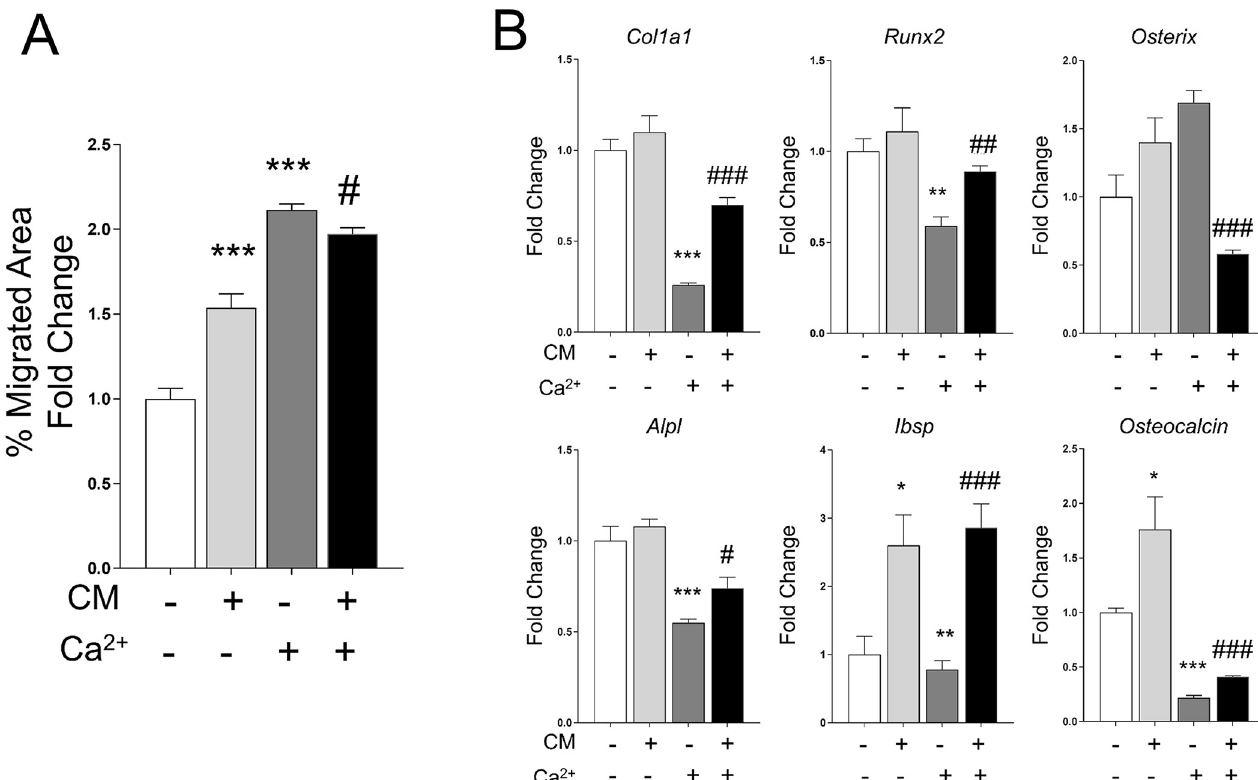
Fig 6. (A) The chemotactic response of primary calvarial cells to 5 mM CaCl 2 alone or in combination with conditioned media was assessed by using a wound healing assay. After 24 hours, the number of migrated cells was quantified. (B) A parallel experiment was performed to assess the osteogenic marker expression, after 48 hours. Data is shown as mean ± SEM. Differences considered significant at � p < 0.05, �� p < 0.01, and ��� p < 0.001 respect to control, and # p < 0.05, ## p < 0.01, and ### p < 0.001 respect to calcium treated